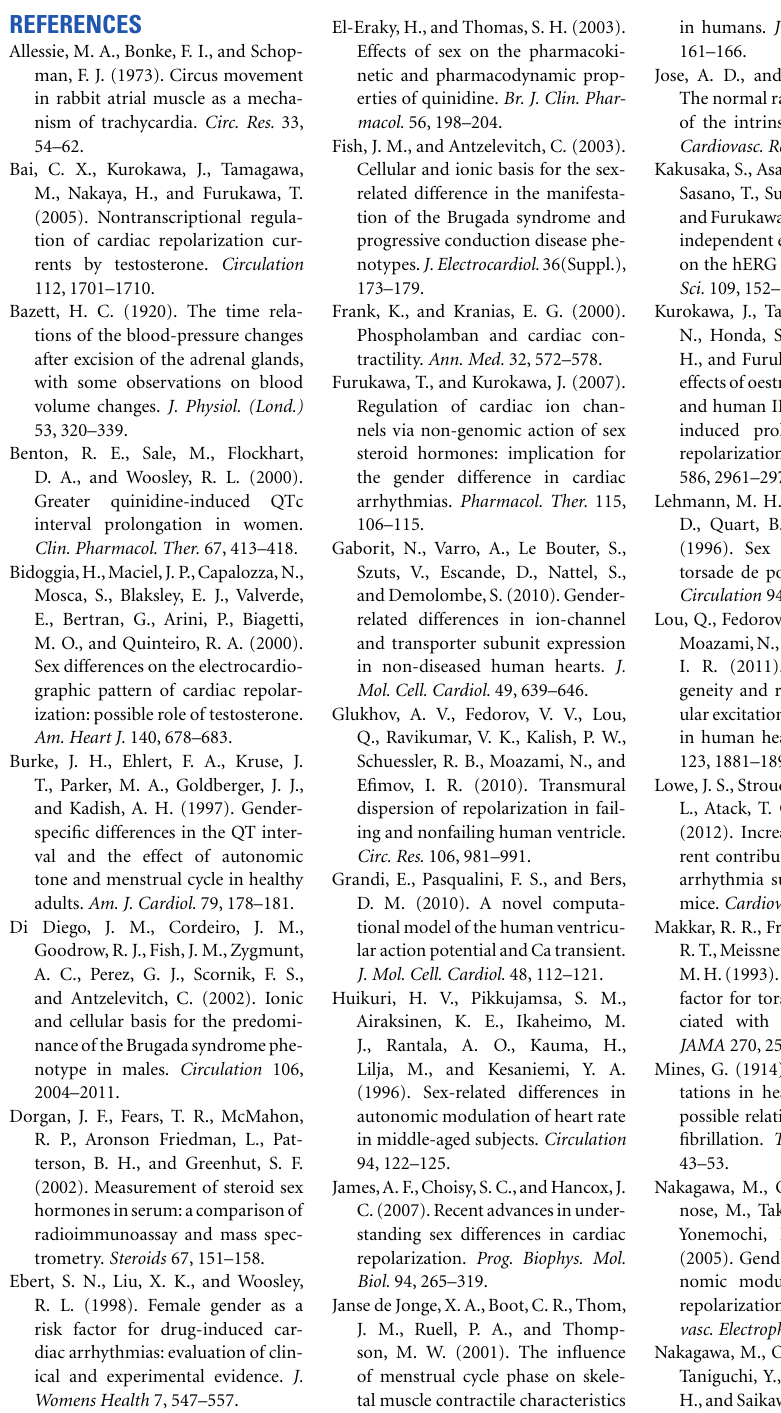
during late follicular phase with drug application. APDs are indicated by color gradient. Figure S7 | Simulated reentry wave on female heterogeneous tissues (Figure S6) in the presence of female hormones (B–D) and I Kr block during early follicular (A) and luteal phases (B). Seven snapshots following application of hormones and/or drug at indicated time points.The same protocol as in Figure 4 was used.